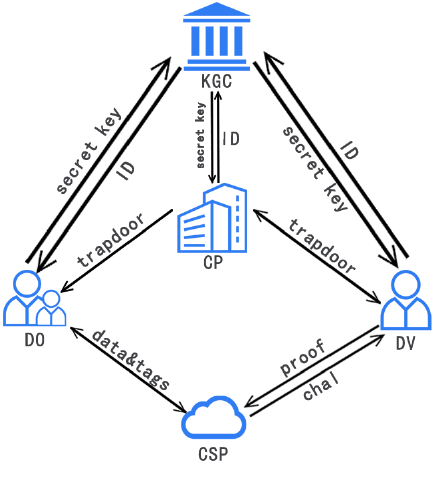
Figure 1. System